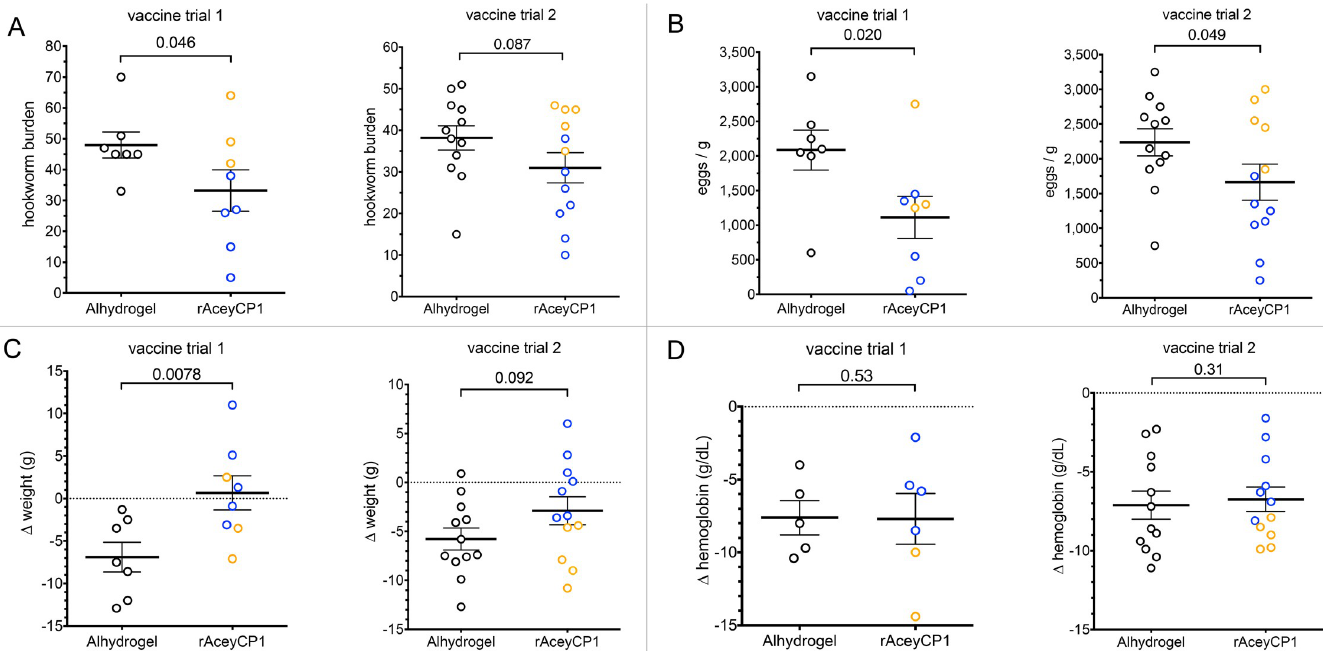
Fig 6. Efficacy results for rAceyCP1/Alhydrogel vaccine trials 1 and 2 with all animals combined. (A) Comparison of mean hookworm burden between rAceyCP1/ Alhydrogel and Alhydrogel control vaccinates. Blue dots indicate serum IgG responders, orange dots indicate serum IgG nonresponders (see Fig 5). (B) Comparison of mean FEC between rAceyCP1/Alhydrogel and Alhydrogel control vaccinates. (C) Comparison of mean change in weight after hookworm infection between rAceyCP1/ Alhydrogel and Alhydrogel control vaccinates. (D) Comparison of mean change in hemoglobin concentration after hookworm infection between rAceyCP1/Alhydrogel and Alhydrogel control